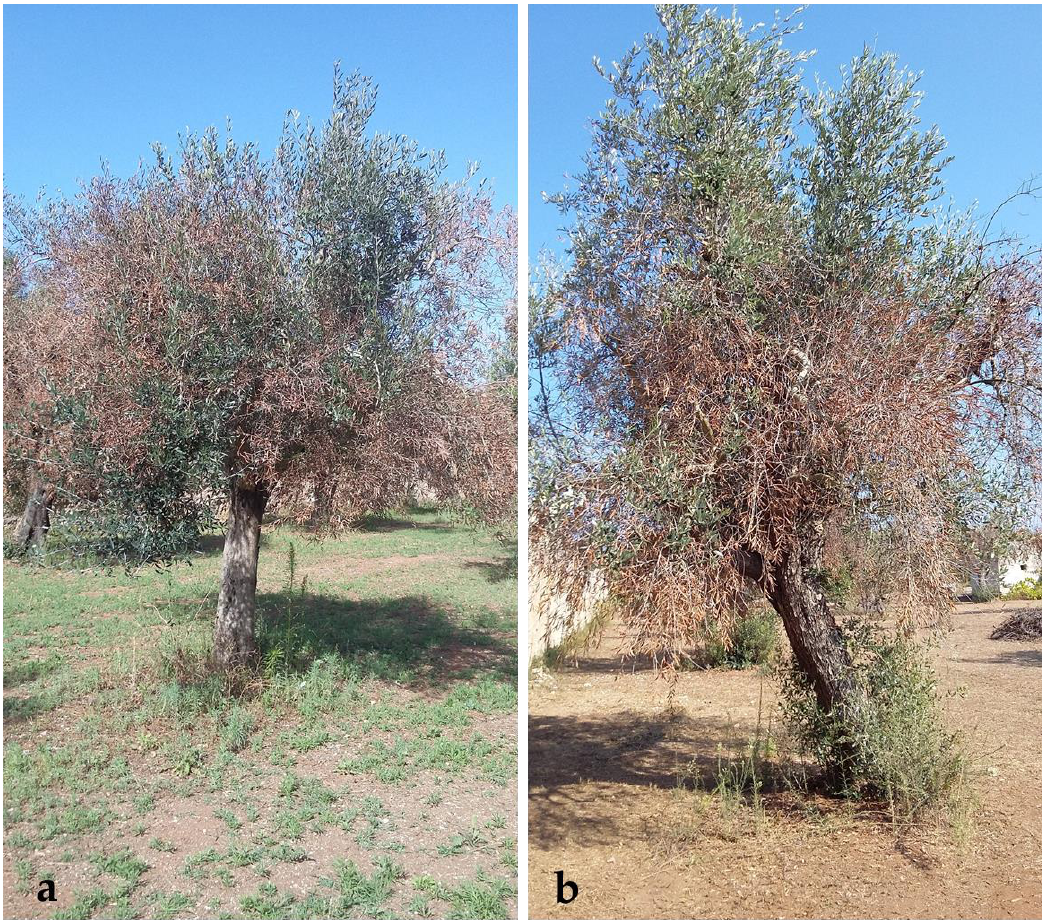
Figure 5. Olive trees studied in municipalities of ( a ) Matino and ( b ) Parabita with symptoms of disease (“olive quick decline syndrome”, OQDS) severity between level 2 to 3.